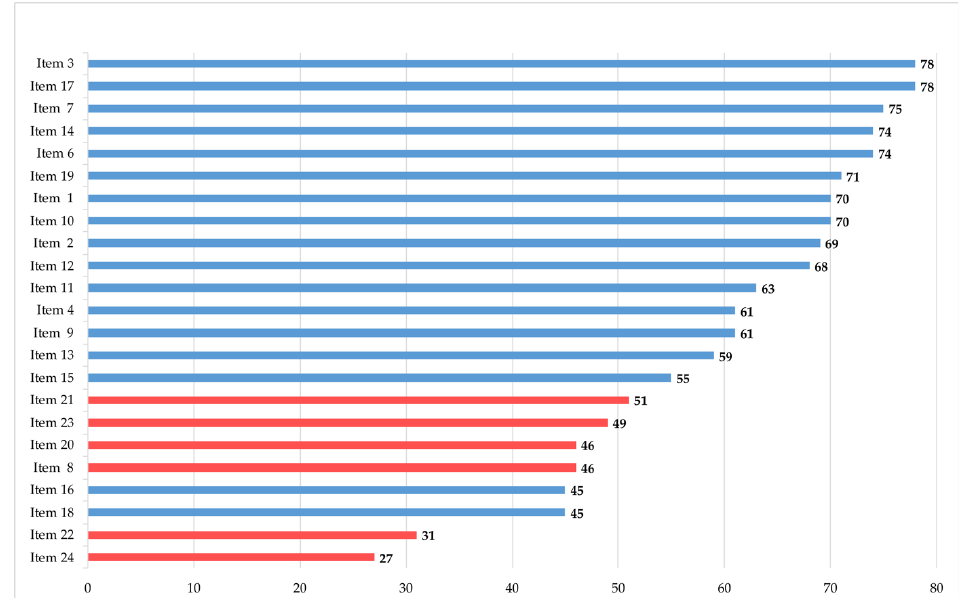
Figure 1. Comparative Self-Assessment (CSA) gains in %. Items included knowledge (blue) and attitude (red).